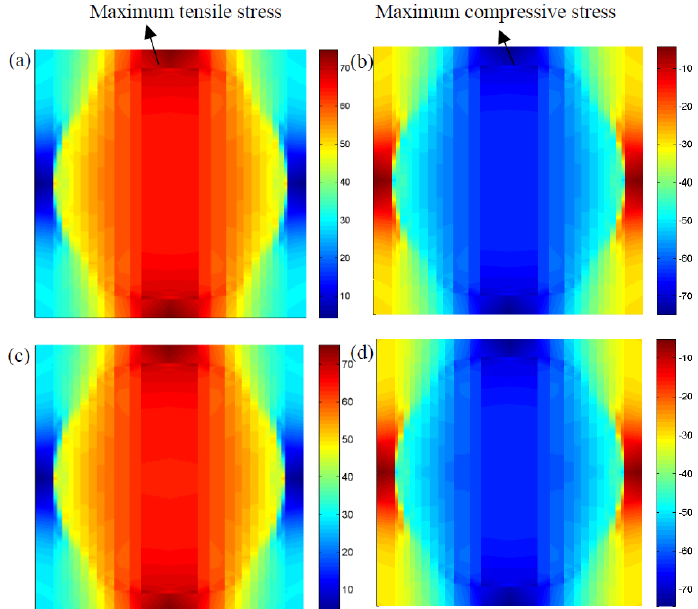
Figure 10. Microscopic stress distributions, σ 22 , of the composites ( a ) without temperature variation at 0.5 s, ( b ) without temperature variation at 1.5 s, ( c ) with temperature variation at 0.5 s, ( d ) with temperature variation at 1.5 s.